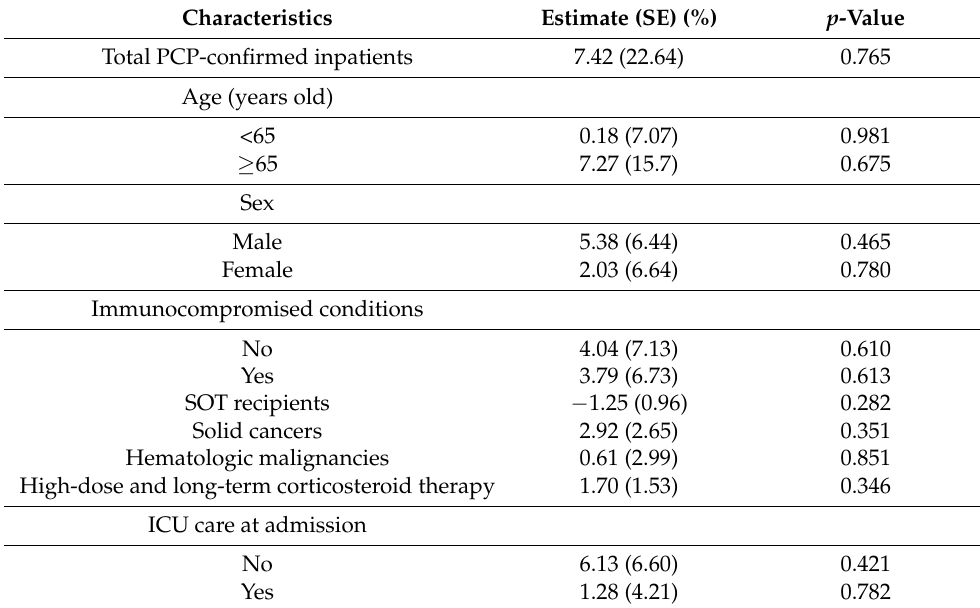
Table 2. Autoregressive integrated moving average analysis to compare the observed and forecasted PCP cases in the post-COVID-19 pandemic